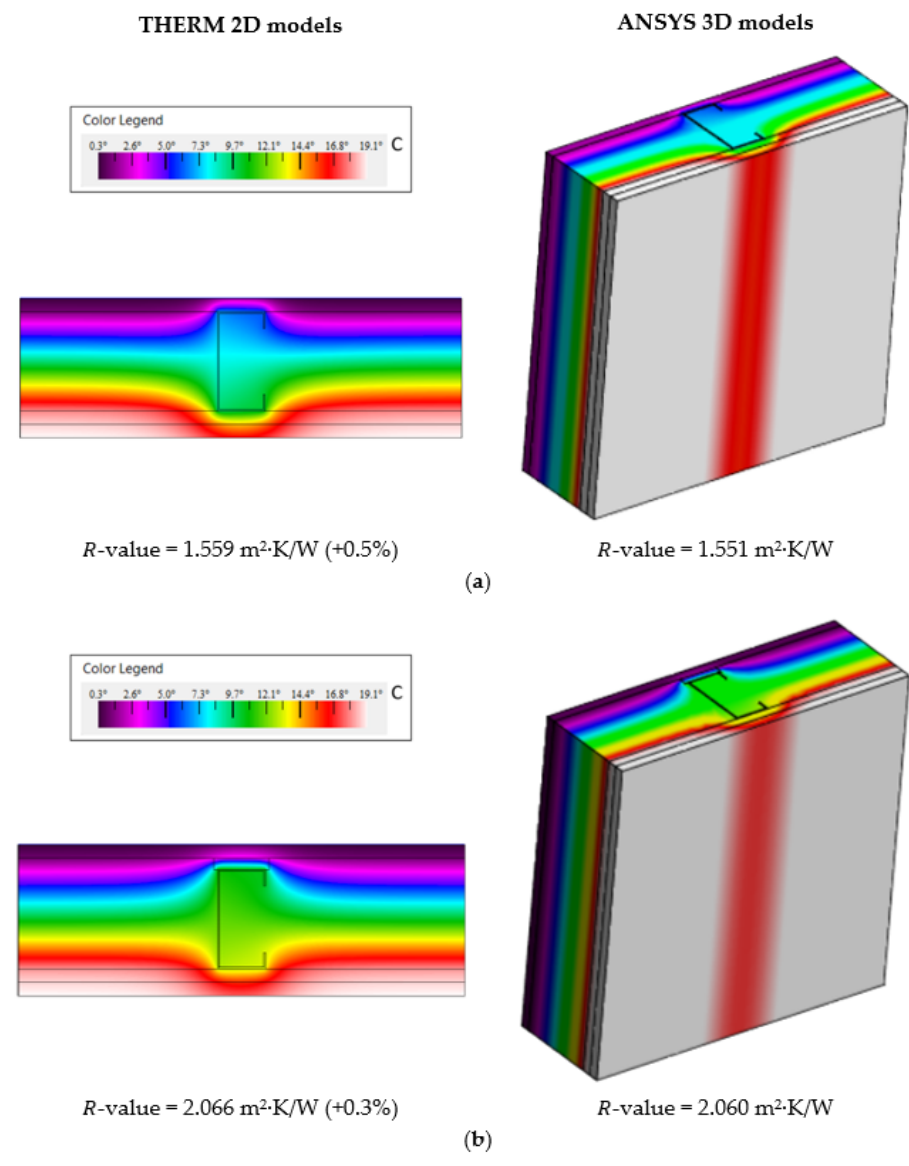
Figure 3. Model accuracy verification of the LSF partitions: predicted temperature distribution and surface-to-surface thermal resistance. ( a ) Reference LSF partition. ( b ) LSF partition with an outer thermal break strip.